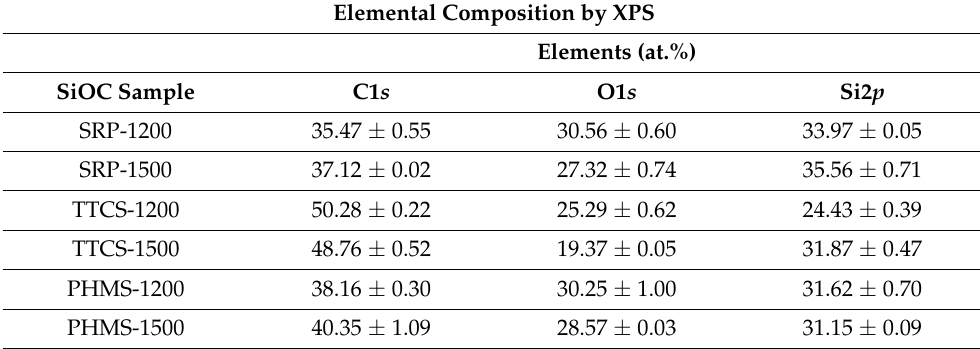
Table 2. Elemental analysis of SiOC samples from